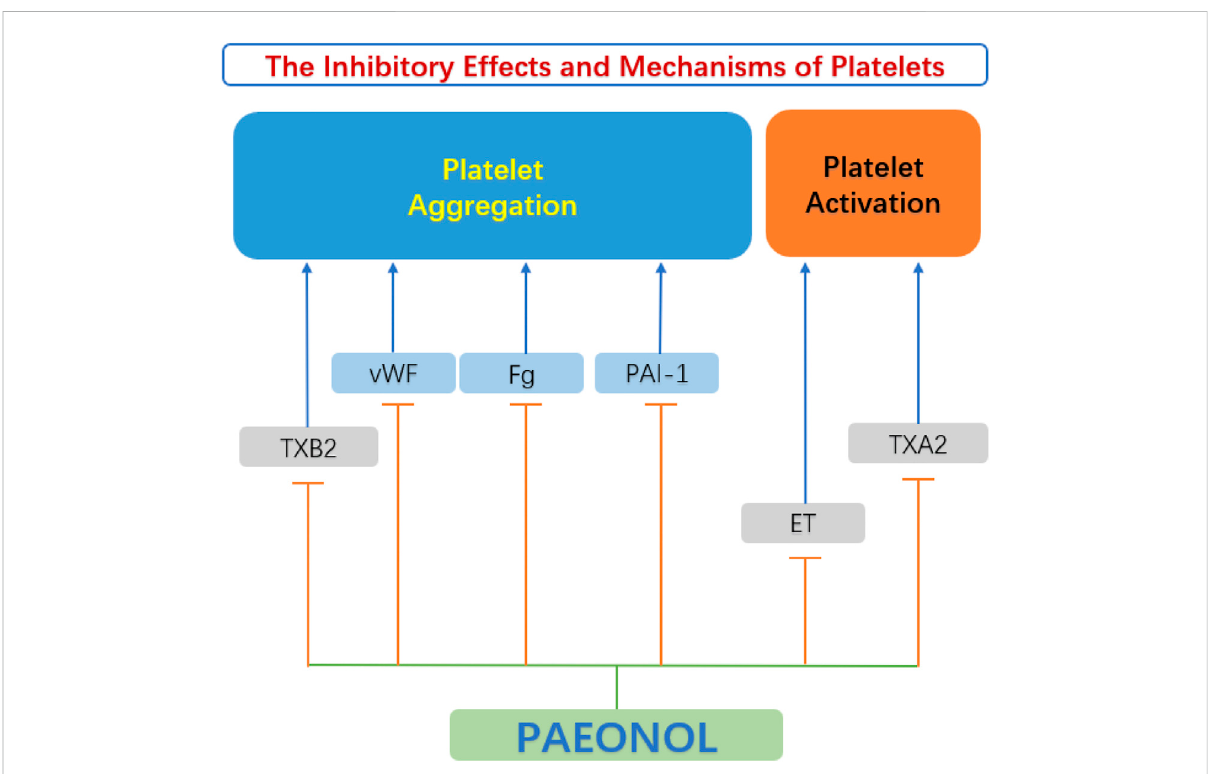
FIGURE 7 Anti-platelet function of paeonol. ET, endothelin; Fg, fi brinogen; PAI-1, plasminogen activator inhibitor 1 gene; TXA2, thromboxane A2; TXB2, thromboxane B2; vWF, von Willebrand